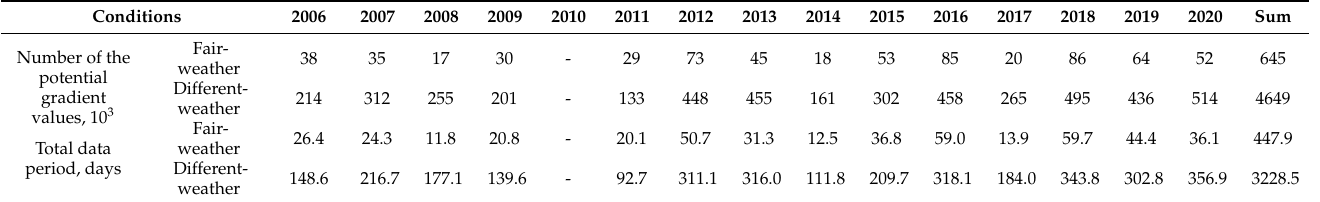
Table A1. Number of potential gradient values (mean per minute) and the total data period under fair-weather conditions and under different weather conditions in Tomsk according to data from the IMCES GO for 2006–2020. Data of potential gradient for 2010 are missing due to the repair and calibration of the field mill in the Voeikov Main Geophysical Observatory (St. Petersburg, Russia).